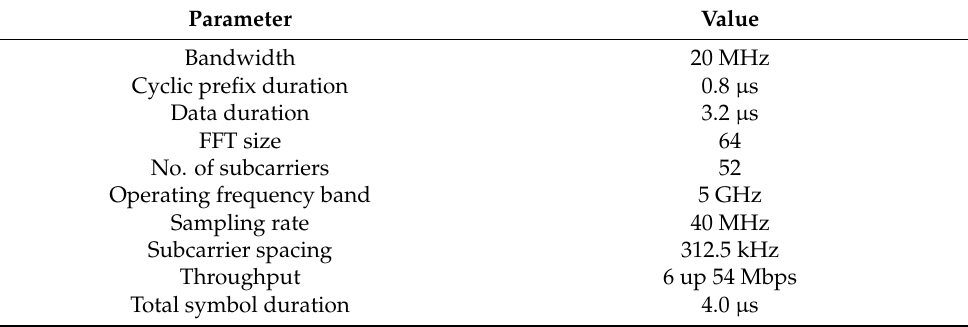
Table 1. Basic parameters of the simulated